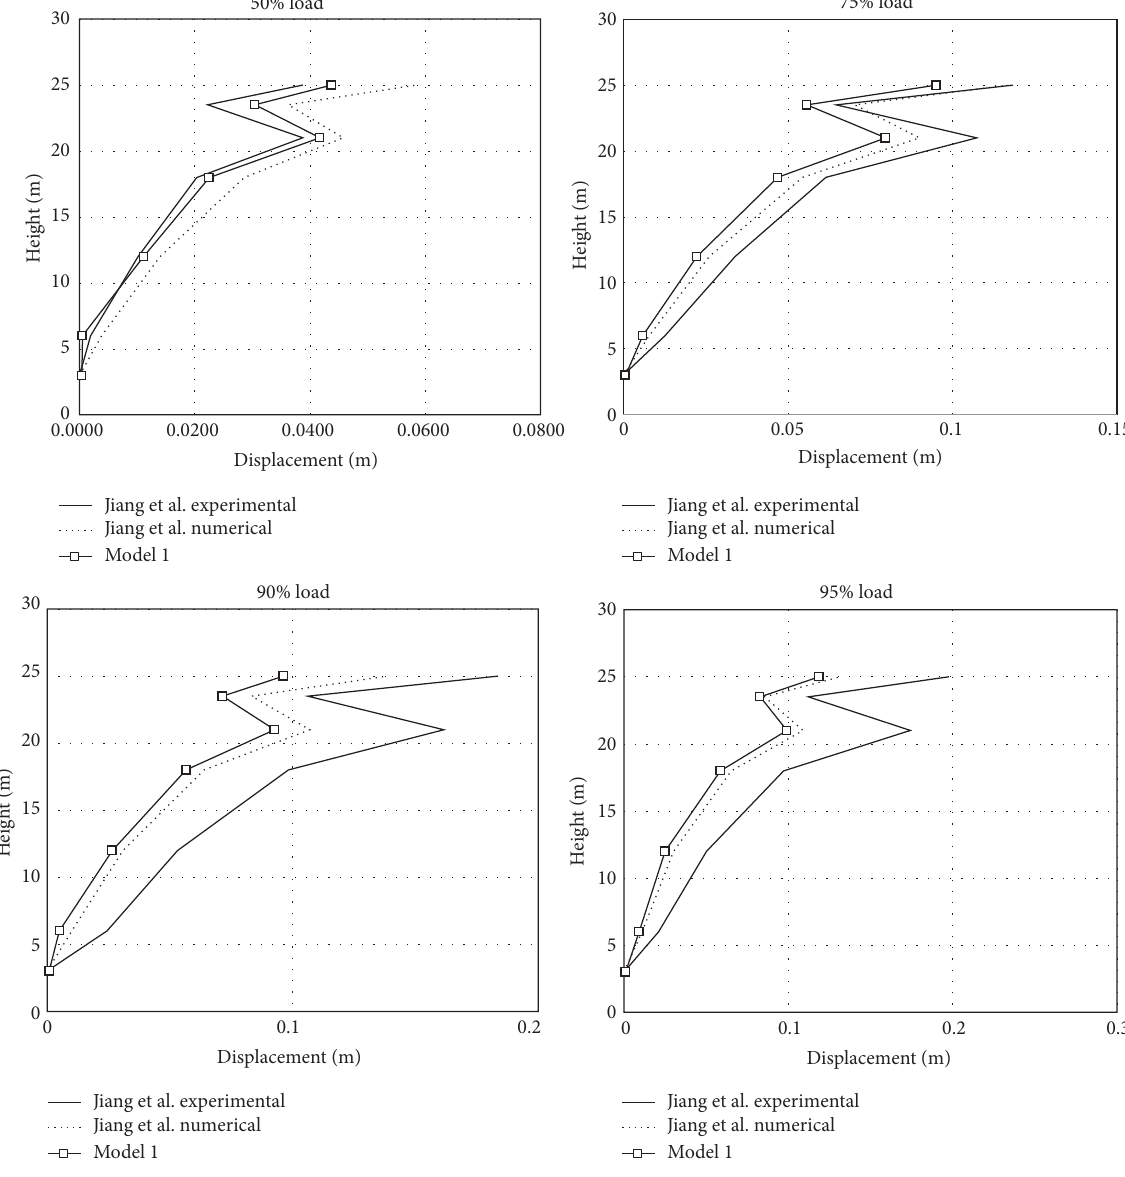
Figure 18: Tower 2 longitudinal displacement at no joint slippage (model